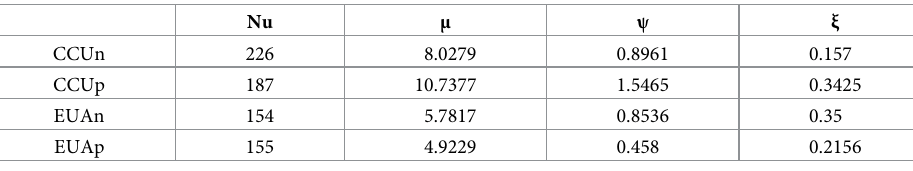
Table 4. The estimated parameters obtained from